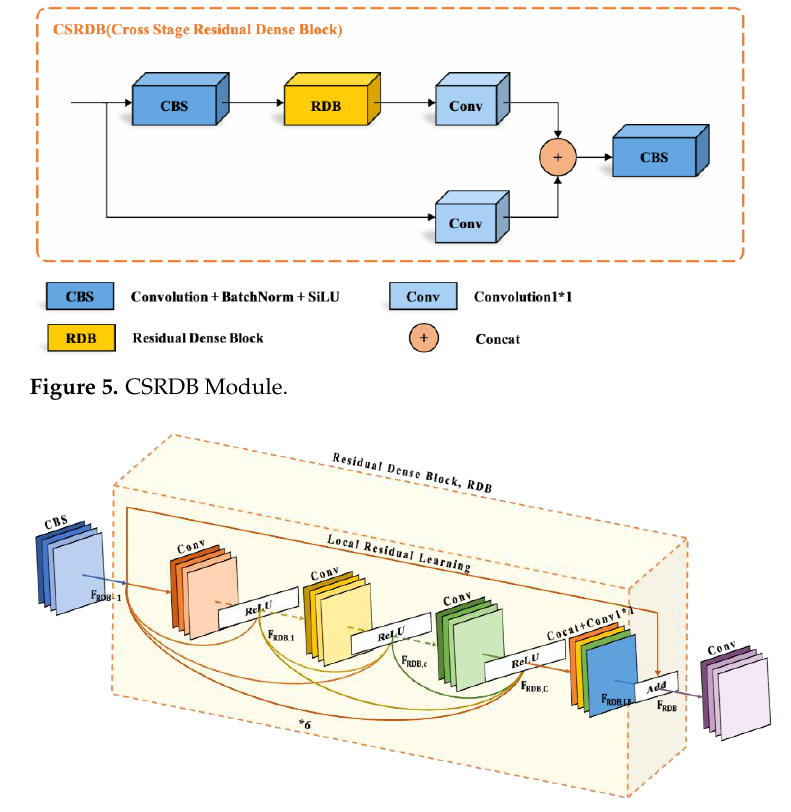
Figure 6. The network structure of Residual Dense Block (RDB).